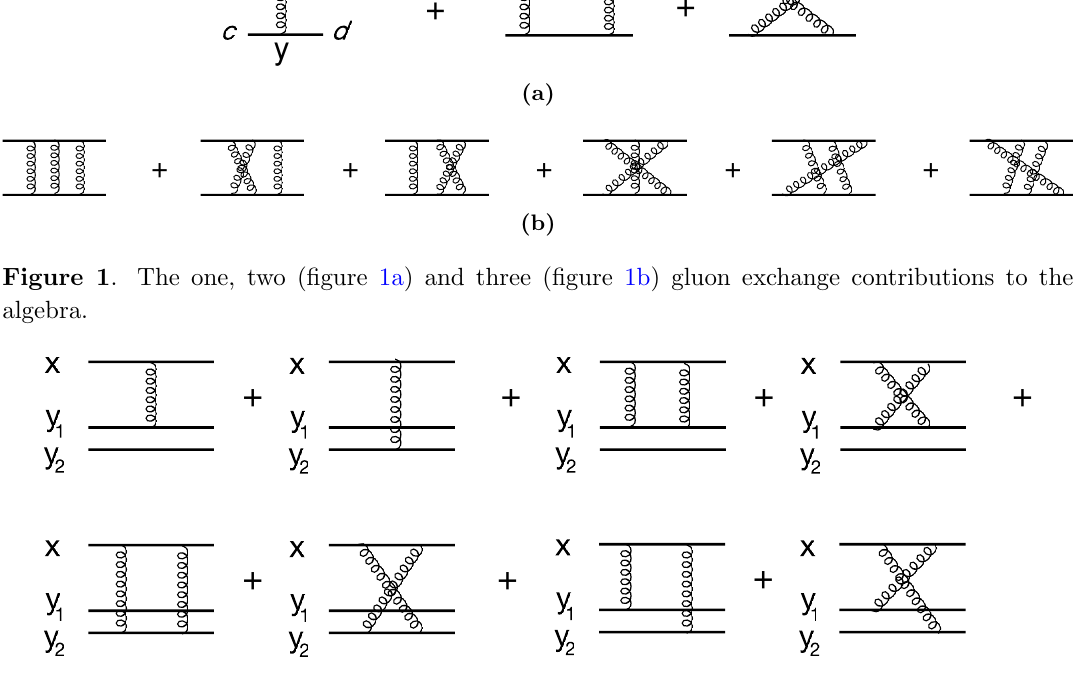
Figure 2 . The one and two gluon exchange contributions to the algebra to one on two